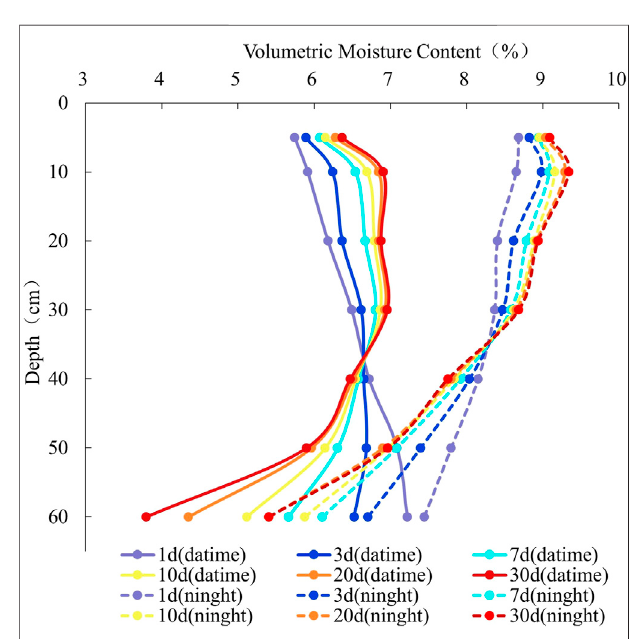
FIGURE13| Matricsuctionofsoilcolumninacyclicdiurnaltemperature variation when the light turns on 14 h (daytime) and turns off 10 h (night) at different